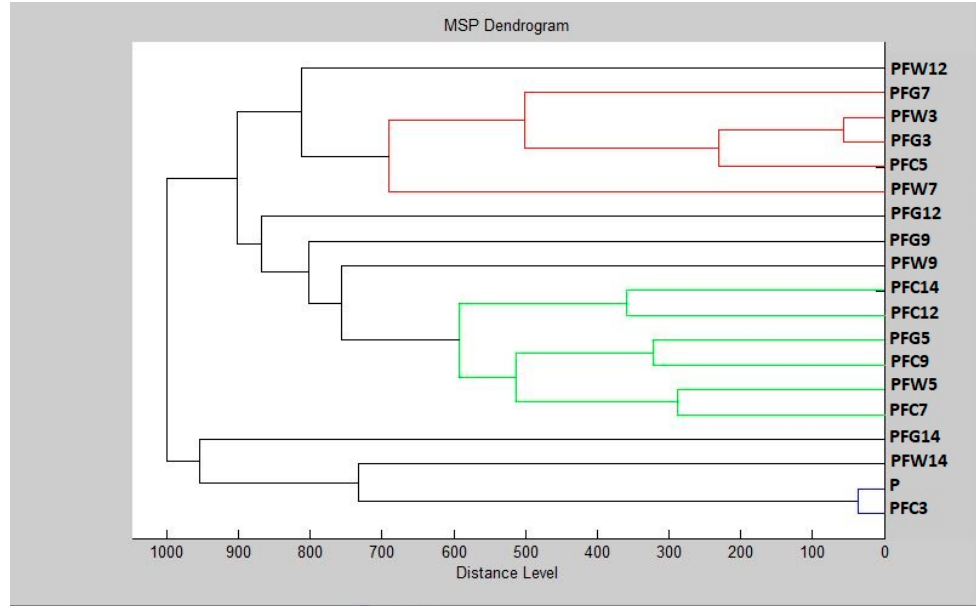
Figure 2. Dendrogram of P. fluorescens generated using the MSPs of the planktonic cells and the control. PF: P. fluorescens ; C: control; G: glass; W: wood and P: planktonic.